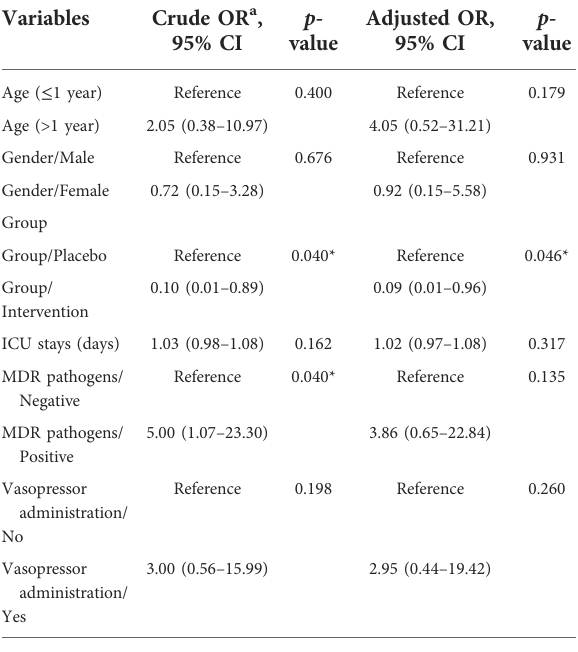
TABLE 6 Factors associated with diarrhea based on univariate and multivariable logistic regression